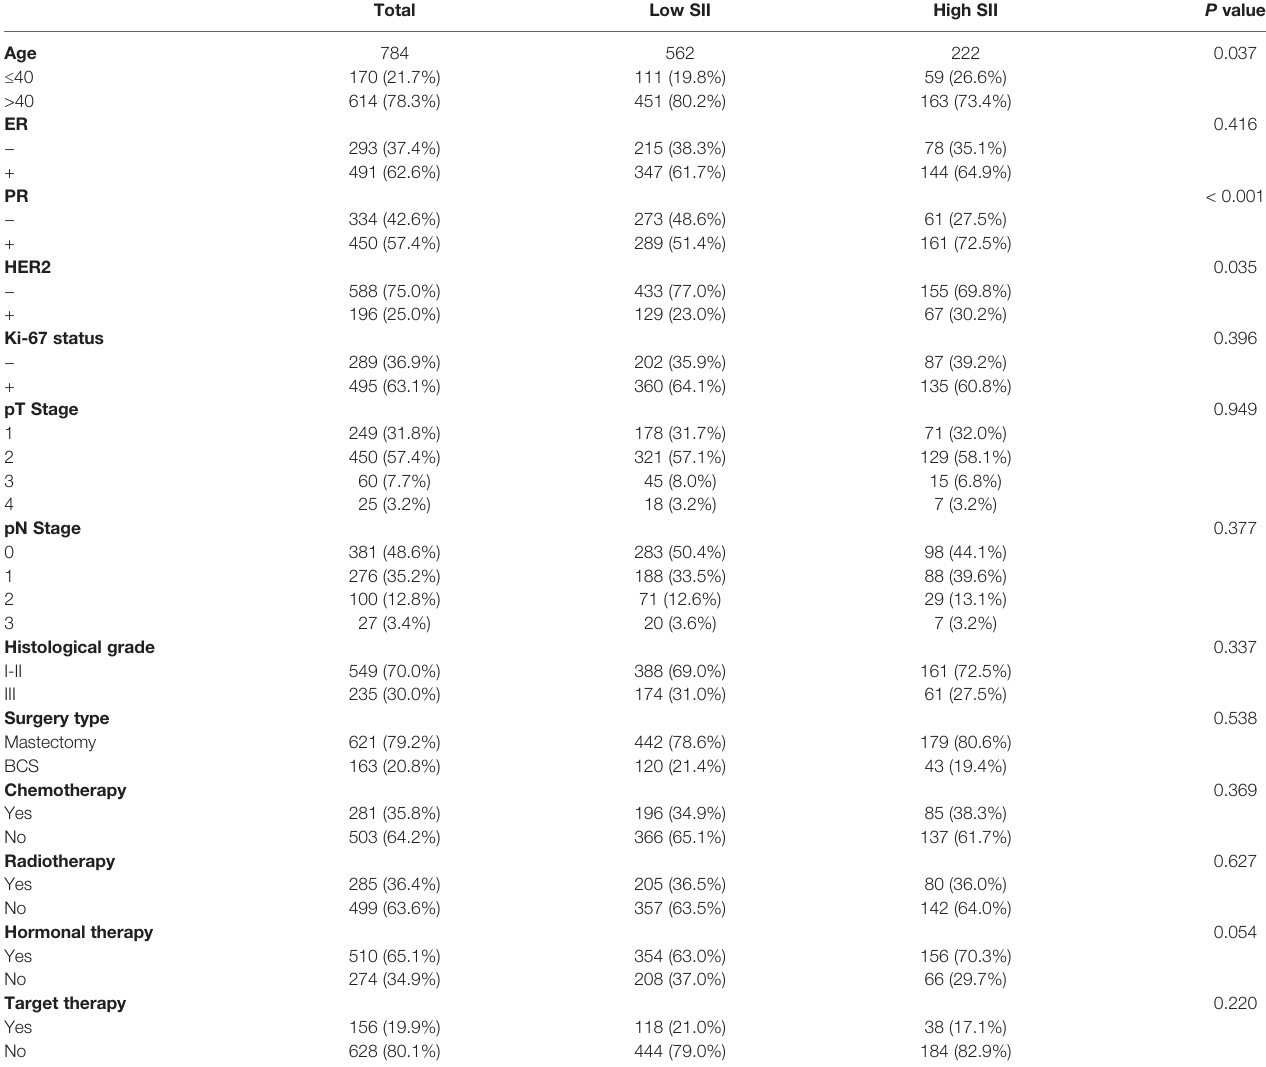
TABLE 1 | Association of the systemic immune-in fl ammation index (SII) with the patient and tumor characteristics.